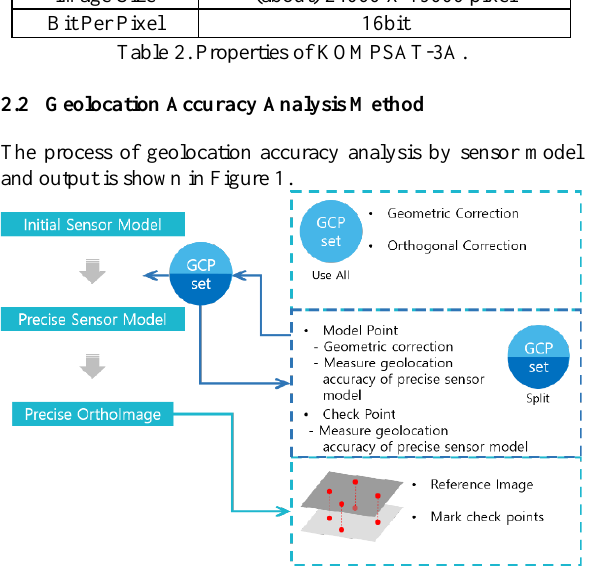
Figure 1. Process of geolocation accuracy analysis.